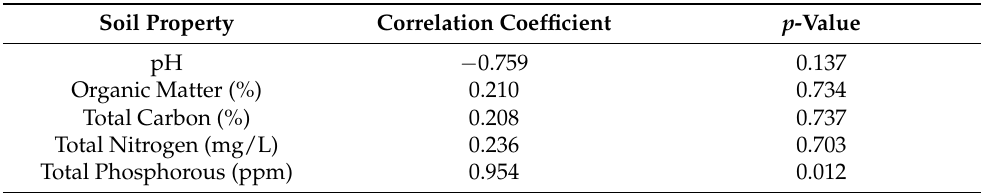
Table 4. Correlation of the average concentration of phosphate solubilized by the isolates with soil properties (Pearson’s